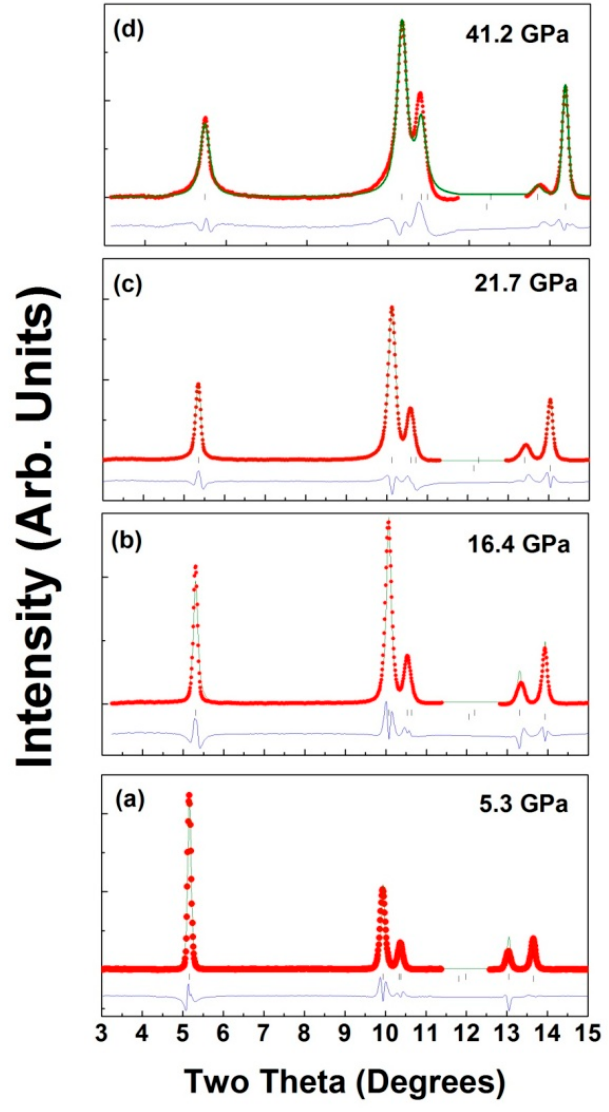
Figure 6. Observed (red), calculated (green), and difference plot (blue) of X-ray powder patterns for LiCrO 2 ( a ) at 5.3 GPa, ( b ) 16.4 GPa, ( c ) 21.7 GPa, ( d ) 41.2 GPa. Top and bottom vertical marks indicate Bragg reflections from the sample and pressure calibrant (Cu).